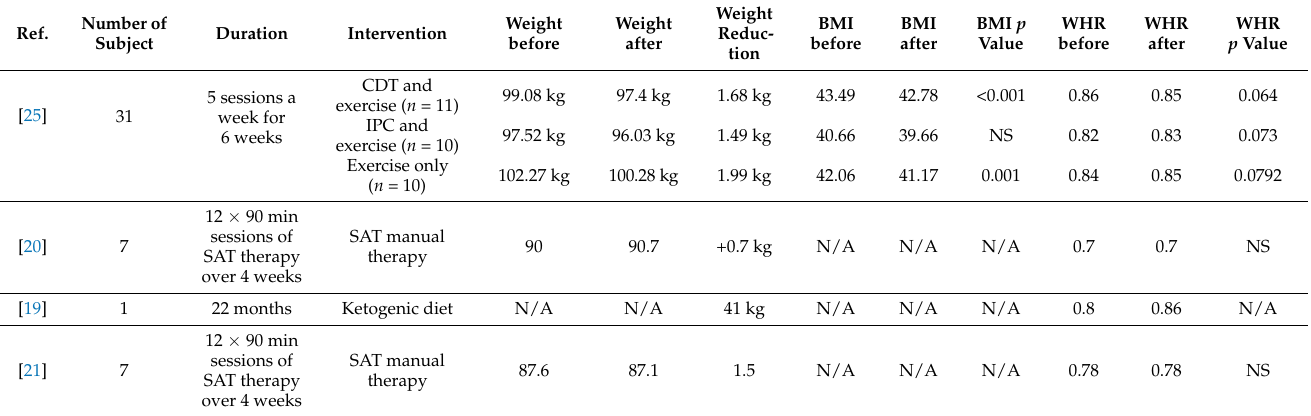
Table 3. The effects of CDT on therapeutic outcome in lipoedema measured with BMI and